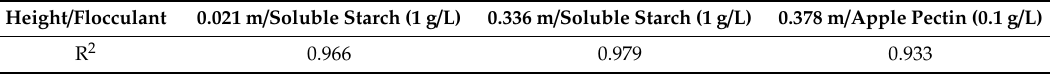
Figure 6. The measured data and modelling curves in each concentration group. Table 2. The coefficient of determination of the concentration curves’ simulation.